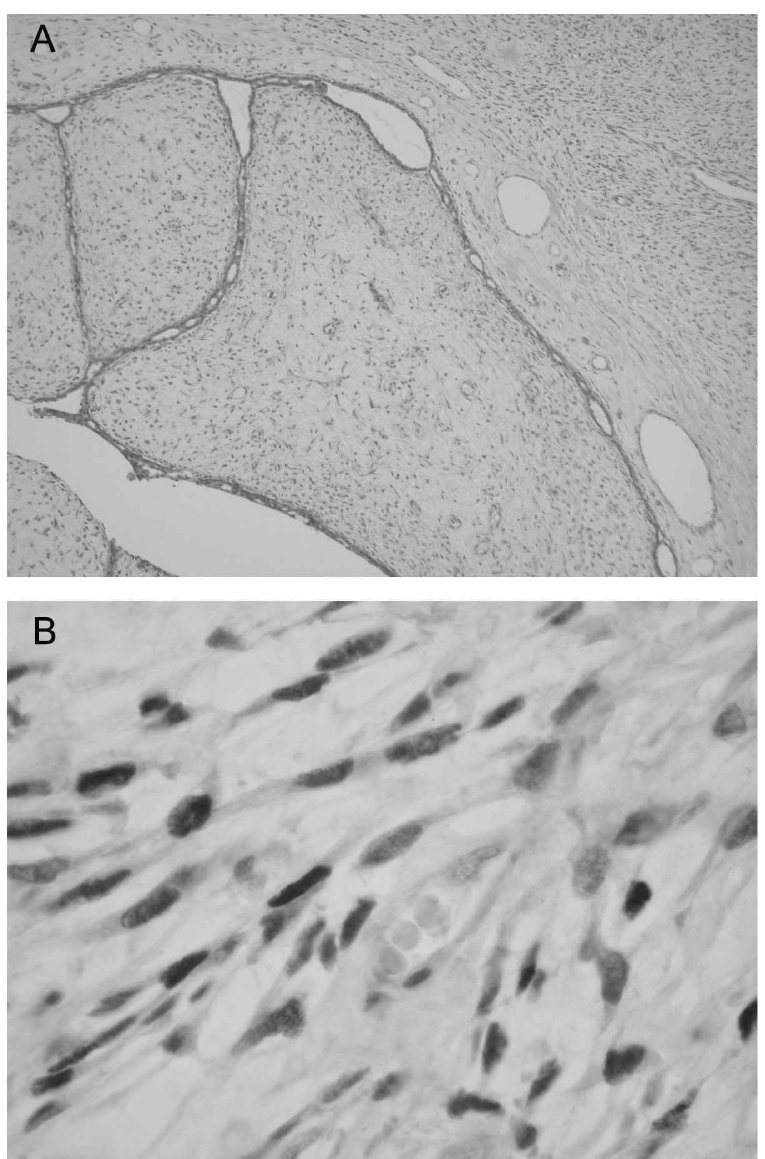
Fig. 1. The borderline phyllodes tumour of the breast. (A) H&E-stained section; (B) p53-immunostained section showing strong nuclear staining of the stromal